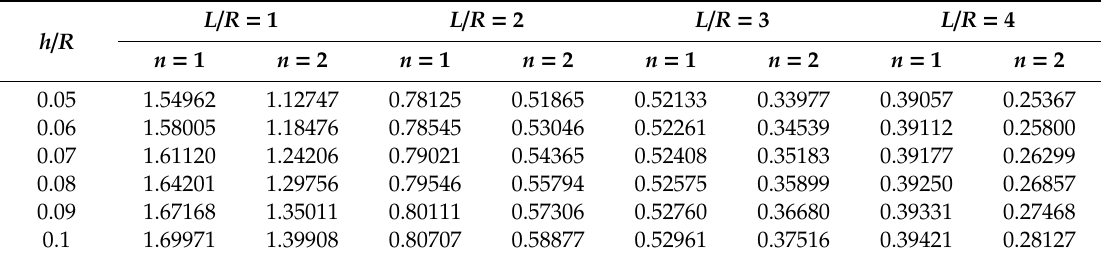
(cid:112) ρ / E 2 for a three-layered cross-ply [0 ◦ / 90 ◦ / 0 ◦ ]